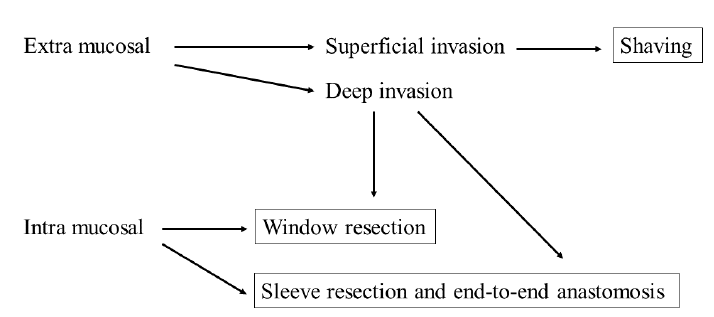
Figure 1. A schema depicting the surgical strategy for tracheal invasion of well-differentiated thyroid cancer according to the extent of